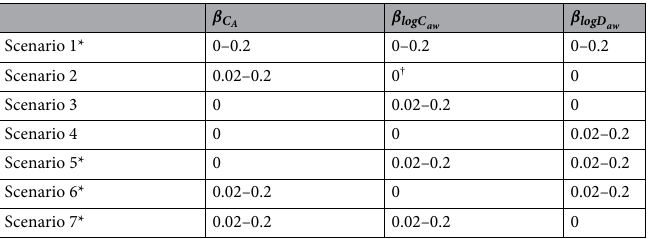
= β logC = β logD = 0, β C = β logC A A aw aw aw